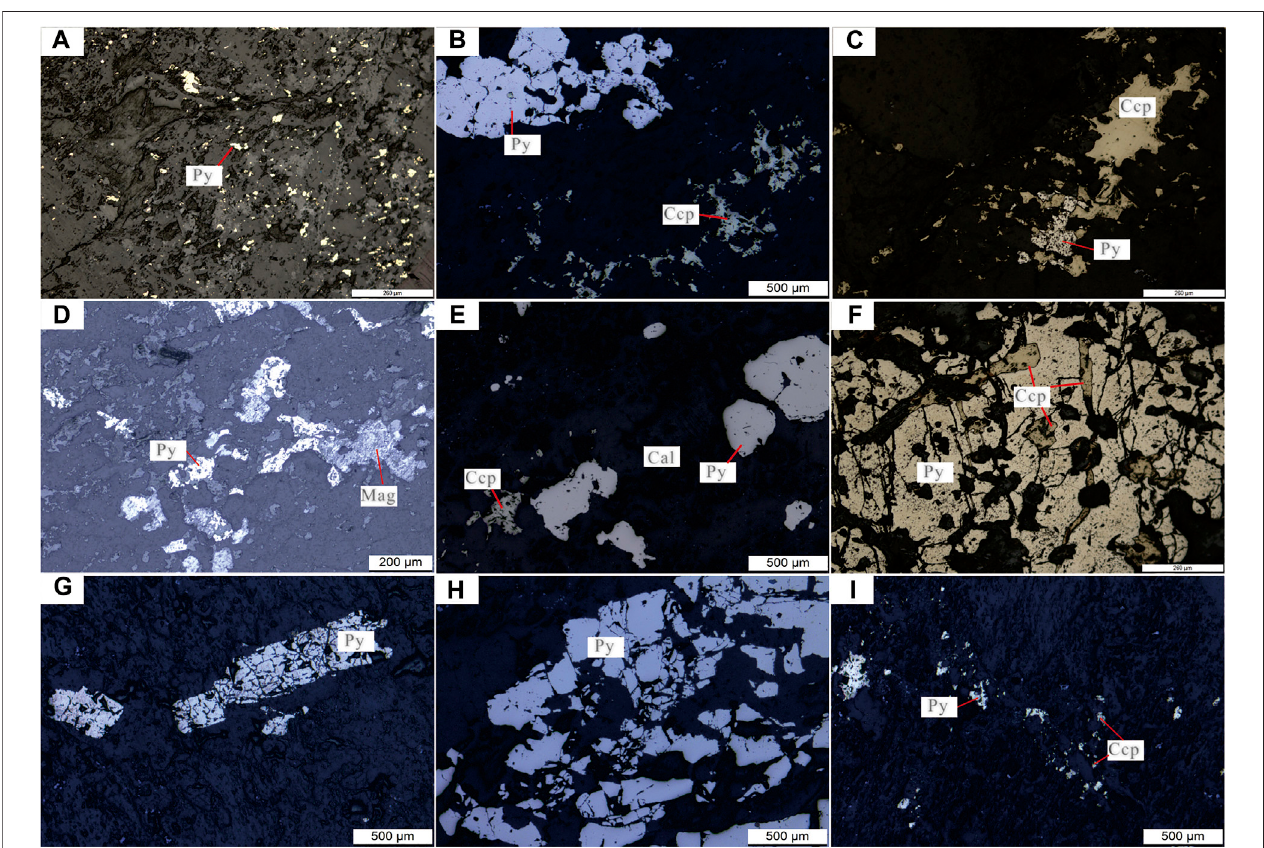
FIGURE 5 | Photomicrographs of pyrite from different mineralization stages in the Tuwu porphyry Cu deposit in eastern Tianshan, Xinjiang, NW China. (A) Disseminatedpyriteinbasaltwithweakpropylitization,Py-I; (B) Pyriteassociatedwithchalcopyriteinplagiograniteporphyry,Py-II 1 ; (C) pyritegrowingalongchalcopyrite fi ssure in plagiogranite porphyry, Py-II 1 ; (D) pyrite associated with magnetite in plagiogranite porphyry, Py-II 2 ; (E) veinlets ofpyrite, chalcopyrite, calcite, and silici in plagiogranite porphyry, Py-II 2 ; (F) chalcopyrite growing along pyrite fi ssure in plagiogranite porphyry in diorite porphyry, Py-III; (G) chlorite, sericite, and pyrite in diorite porphyrite, pyrite with crushed structure, Py-III; (H) sericite and pyrite in plagiogranite porphyry, pyrite with crushed structure, Py-III; and (I) chlorite and sericite in diorite porphyrite with pyrite and chalcopyrite vein. Ccp, chalcopyrite; Py, pyrite; Mag, magnetite; Qtz, quartz; Cal, calcite; Ser, sericite.